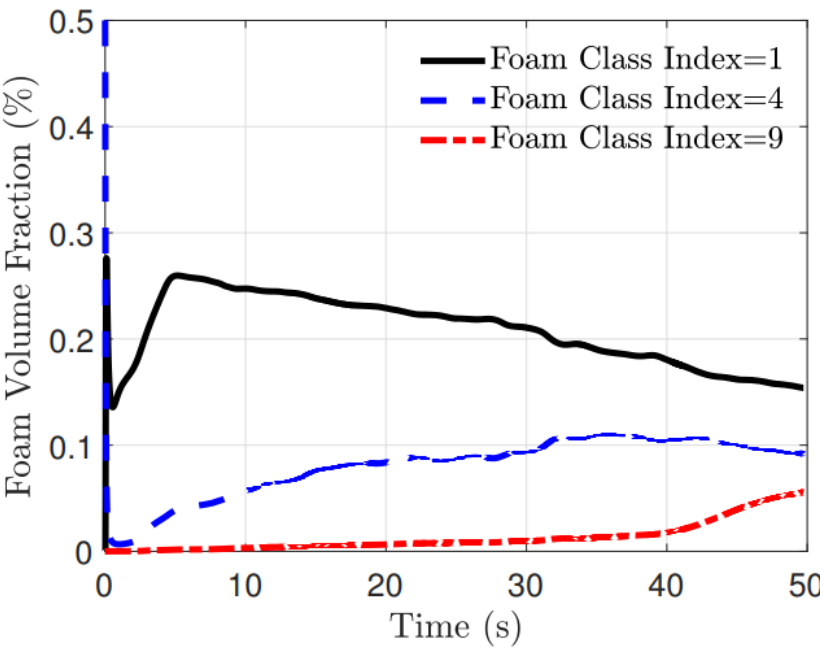
Figure 9. Time history of the volume fraction of the foam phase, where the surface tension is σ = 0.055.